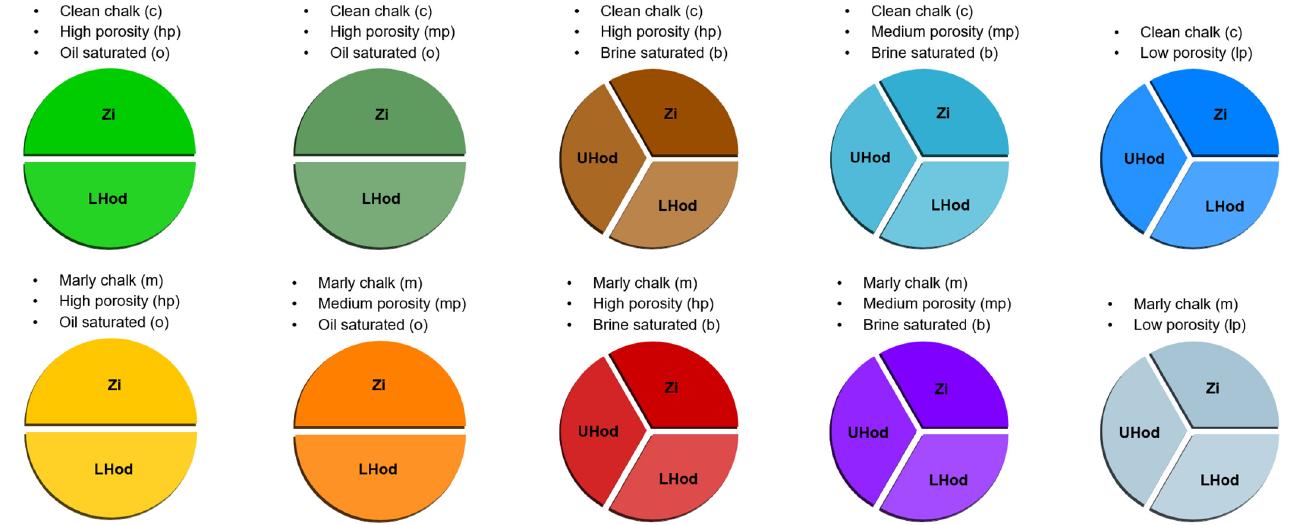
Figure 6. Facies class legend. The presented facies classes focus on the three main zones within the target interval: Ekofisk-Tor (Zone of interest: Zi), Upper Hod (UHod) and Lower Hod (LHod). An a priori probability model for the facies was defined from regional interpreted horizons, assuming equal proportions of the relevant facies classes inside the various zones. The a priori local spatial structure of the facies was formulated as a 1D Markov process [22] sampled from the facies thickness distributions from well observations (Fig- ure 7).